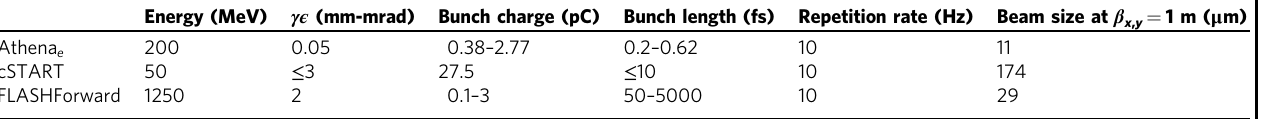
Table 1 Major beam parameters of research projects for a plasma-wake fi eld acceleration-based injector relevant for our case study 22 – 24